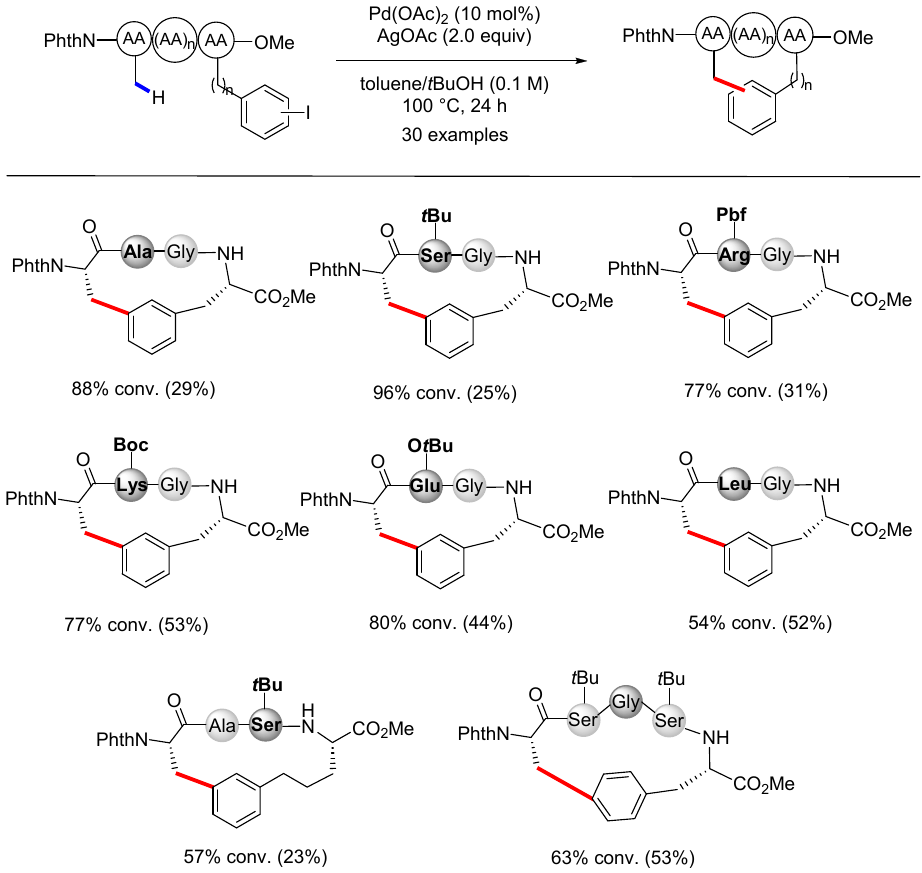
Figure 18. Stapled peptides obtained via Pd(II) ‐ catalyzed intramolecular C(sp 3 ) − H arylation [83]. Almost at the same time, Wang and co ‐ workers also demonstrated an analogous macrocyclization via the intramolecular β ‐ C(sp 3 ) − H arylation of amino acids at the N ‐ terminus of the peptides, which could proceed smoothly in both solution ‐ phase and solid ‐ phase peptide synthesis approaches (Figure 19) [84]. In this protocol, 1,2 ‐ dichloroethane (DCE) was used as the solvent to achieve remarkable efficiency. This approach tolerated a broad scope of peptide substrates, including tetra ‐ and pentapeptides, delivering a diverse variety of polypeptide macrocycles bearing C β –Ar cross ‐ links between the β ‐ carbon of amino acids and the aromatic ring of Phe/Trp, with satisfactory diastereoselectivity. Successfully, the authors applied this macrocyclization methodology to the total synthesis of the key fragment in the bioactive natural product celogentin C.